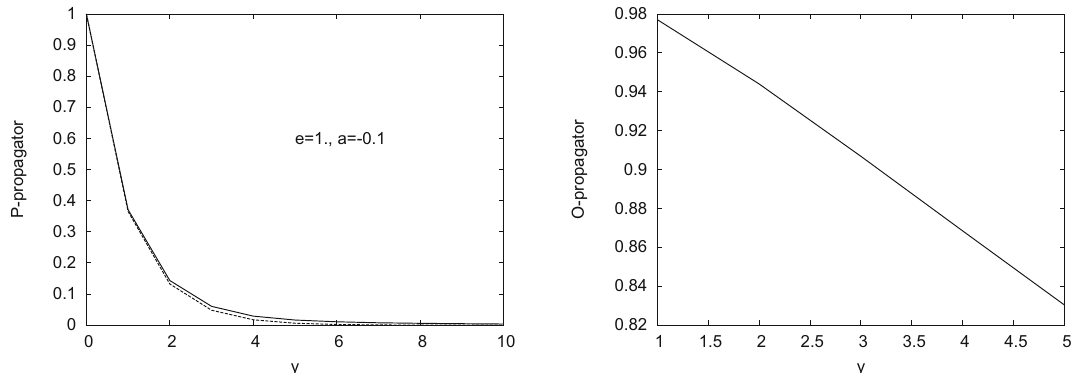
Fig. 7 The solid curves show pomeron (left panel) and odderon (right panel) propagators as functions of rapidity for μ = − 1, λ = 0 . 1. The dashed curve in the left panel shows the pomeron propagator in absence of the odderon (only pomeron loops)